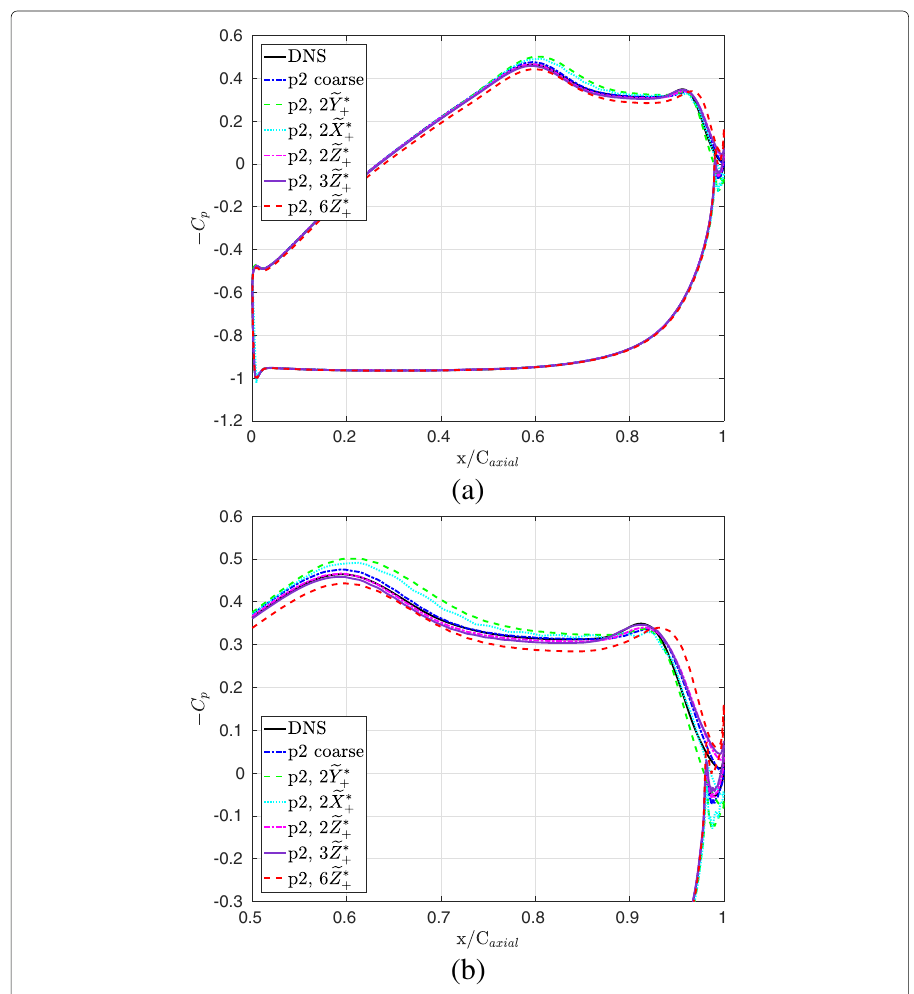
Fig. 12 Comparison of the time- and spanwise-averaged coefficient of pressure for coarse LES simulations. Note that the starred resolution ( (cid:14) X ∗ + , (cid:14) Y ∗ + , (cid:14) Z ∗ + ) = ( 20,0.96,22 ) corresponds to the p2 coarse case. ( a ) global view over the blade ( b ) enlarged view near the trailing edge